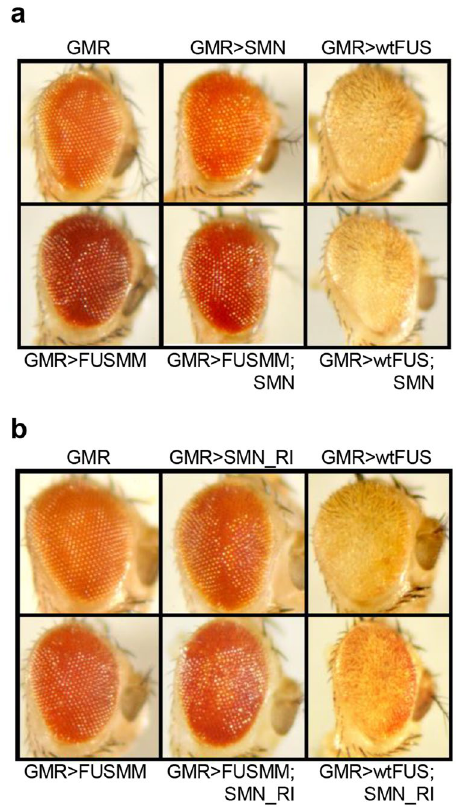
Figure 7. Alteration of SMN levels does not affect FUS-induced eye degeneration in Drosophila. ( a ) Representative pictures showing eyes from flies expressing the indicated human genes under the control of GMR GAL4. Fly lines carrying UAS::flag-FUS wild-type or UAS::flag-FUSMM transgenes on the second chromosome, together with GMR-GAL4, were grown at 29 °C. Flies expressing UAS::flag-SMN on its own were crossed with the GMR-GAL4 driver, at 29 °C. wtFUS induces a very strong eye degeneration, while expressing either FUSMM or SMN separately determines only very mild alterations of eye morphology. Significantly, the simultaneous expression of flag-SMN does not affect the strong eye degeneration caused by wtFUS. ( b ) Representative pictures showing eyes from flies expressing the indicated human genes under the control of GMR GAL4. RNAi mediated downregulation of Smn gene expression in fly eyes (SMN_RI) was obtained by expressing a specific RNAi construct (P (TRiP.HMC03832) attP40) at 29 °C, in a hemizygous background for Smn (Df (3 L)